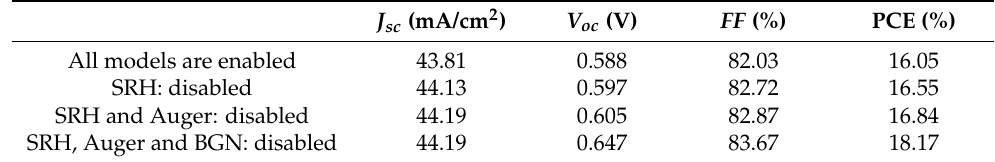
Figure 9. Illuminated J–V characteristics of the flipped npn structure for different models’ impact. Table 3. Photovoltaic parameters for the flipped microstructure when deactivating different mod- els.